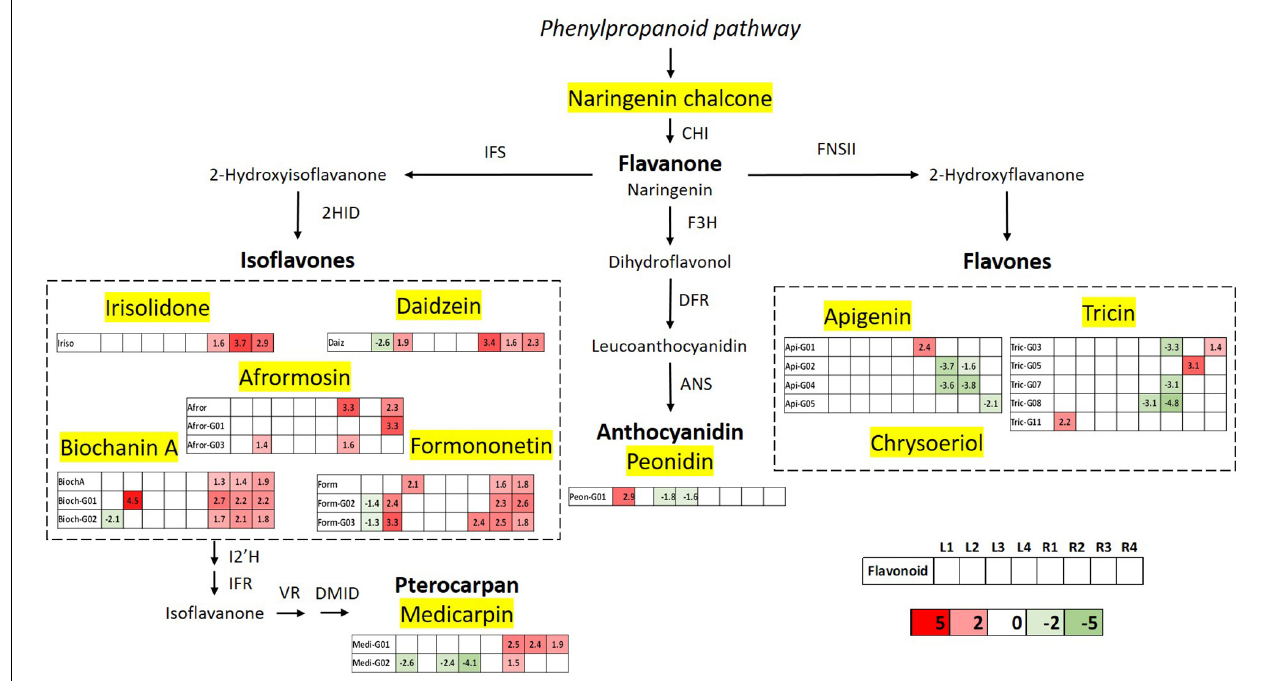
FIGURE 9 | Schematic diagram of the flavonoid biosynthesis pathway integrating the metabolomics results of differentially accumulated flavonoids upon Hg stress in Medicago truncatula leaf and root samples. Differentially expressed flavonoids are displayed in a color code based on the Log 2 FC value; downregulated flavonoids (Log 2 FC < 1.33) are indicated in green and upregulated components (Log 2 FC > 1.33) are shown in red. CHI, chalcone isomerase; IFS, isoflavone synthase; F3H, flavanone 3 β -hydroxylase; 2HID, 2-hydroxyisoflavanone dehydratase; DFR, dihydroflavonol-4-reducatse; FNSII, flavone synthase; ANS, anthocyanidin synthase; I2’H, isoflavone 2’-hydroxylase; IFR, isoflavone reductase; VR, vestitone reductase; and DMID, dihydroxy-40-methoxy-isoflavanol